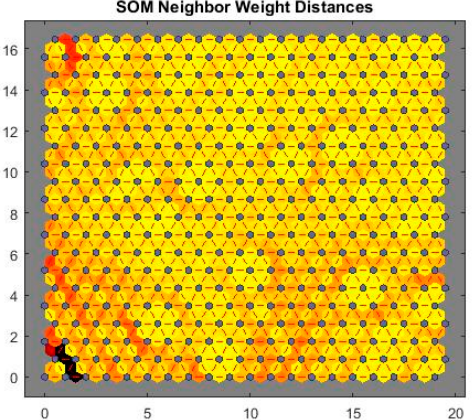
Figure 4. U-Matrix (unified distances matrix).